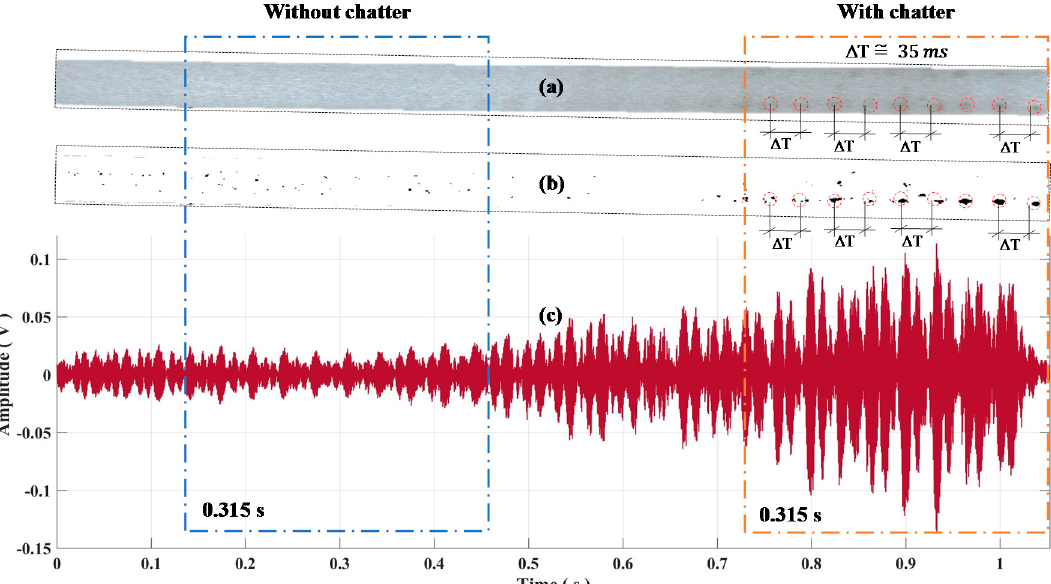
Figure 1. Picture of the workpiece surface after the grinding process ( a ) without image processing and ( b ) with image processing; ( c ) vibration signal during the grinding process.